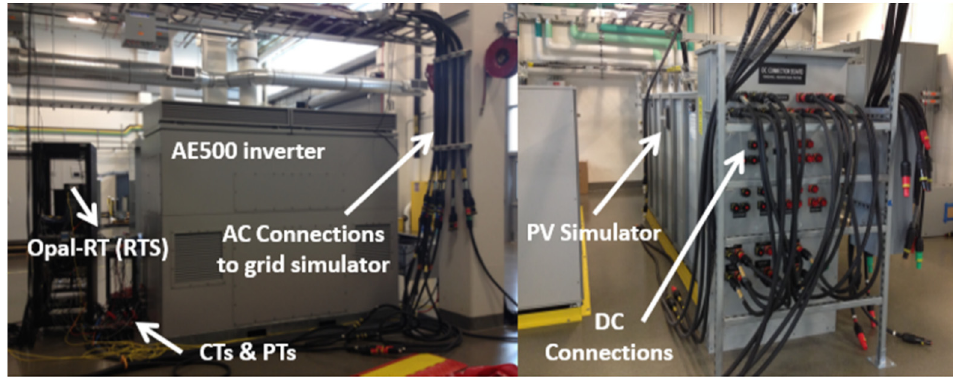
Figure 12. NREL PHIL laboratory hardware setup of the presented case study [Courtesy of NREL].